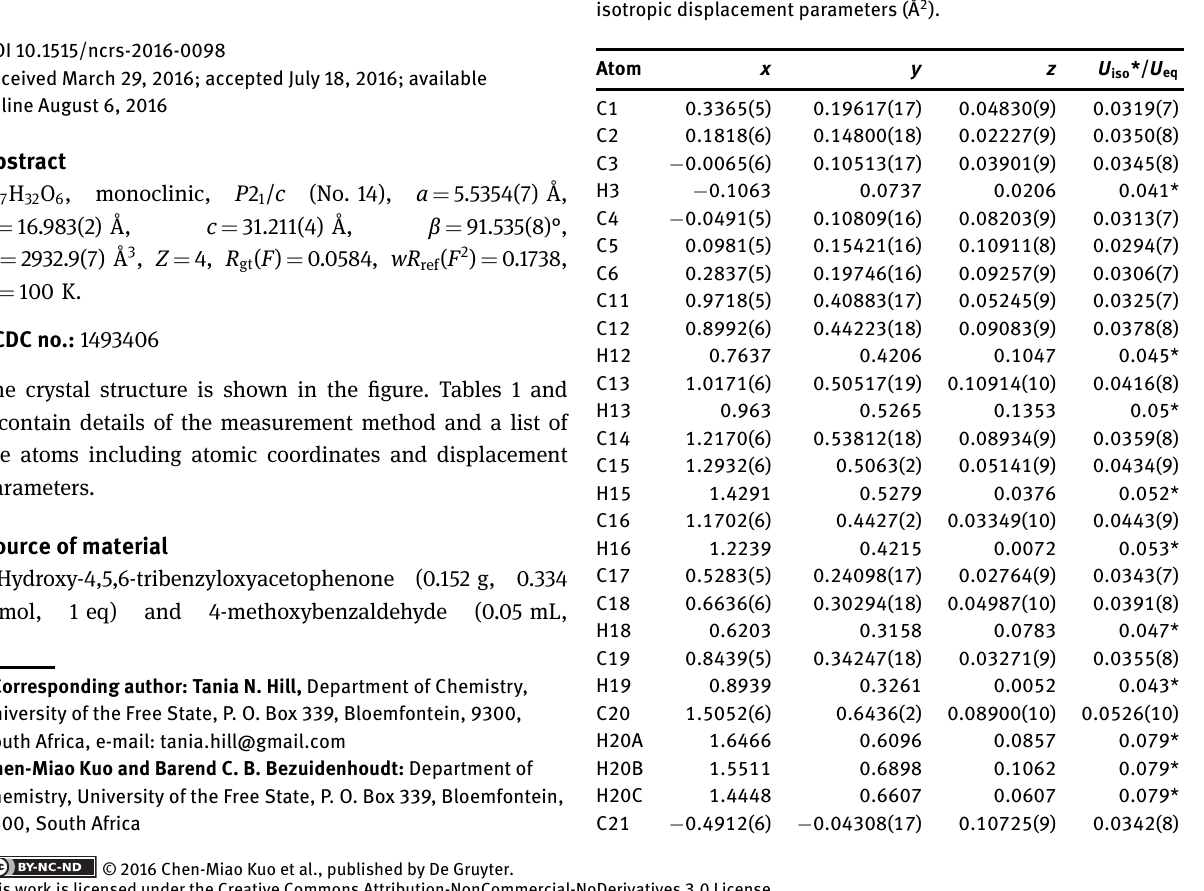
Table 2: Fractional atomic coordinates and isotropic or equivalent isotropic displacement parameters (Å 2